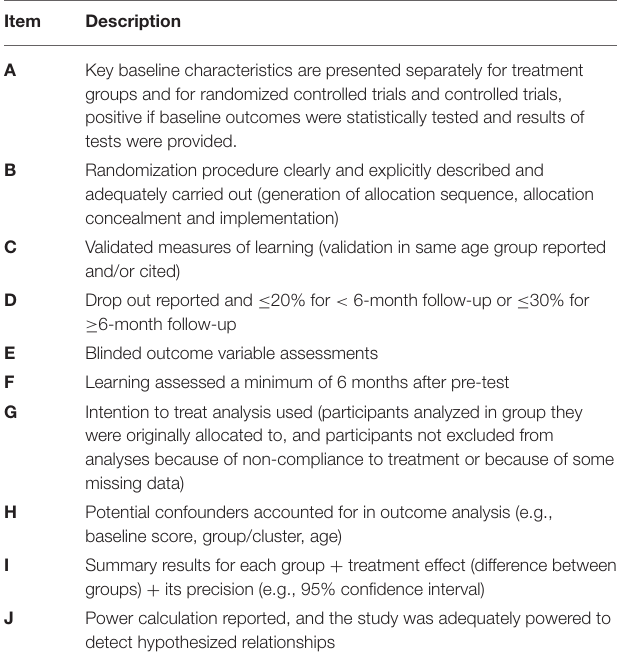
TABLE 2 | Methodological quality assessment items (Adapted from Van Sluijs et al., 2007).